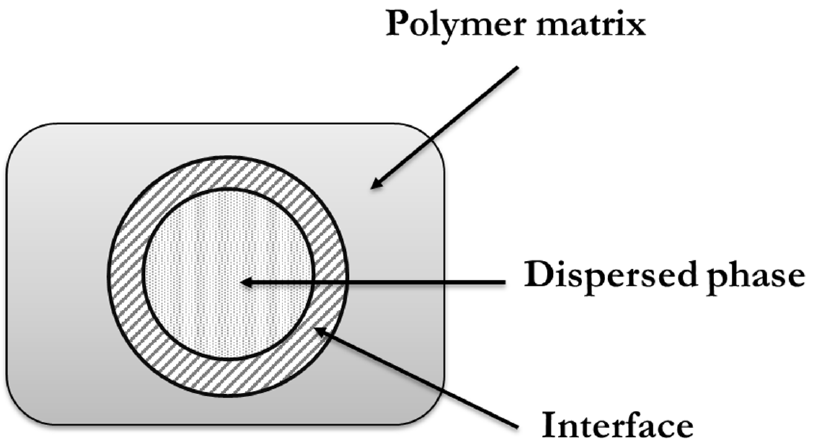
Figure 10. Schematic representation of polymer matrix, dispersed phase, and their interphase.